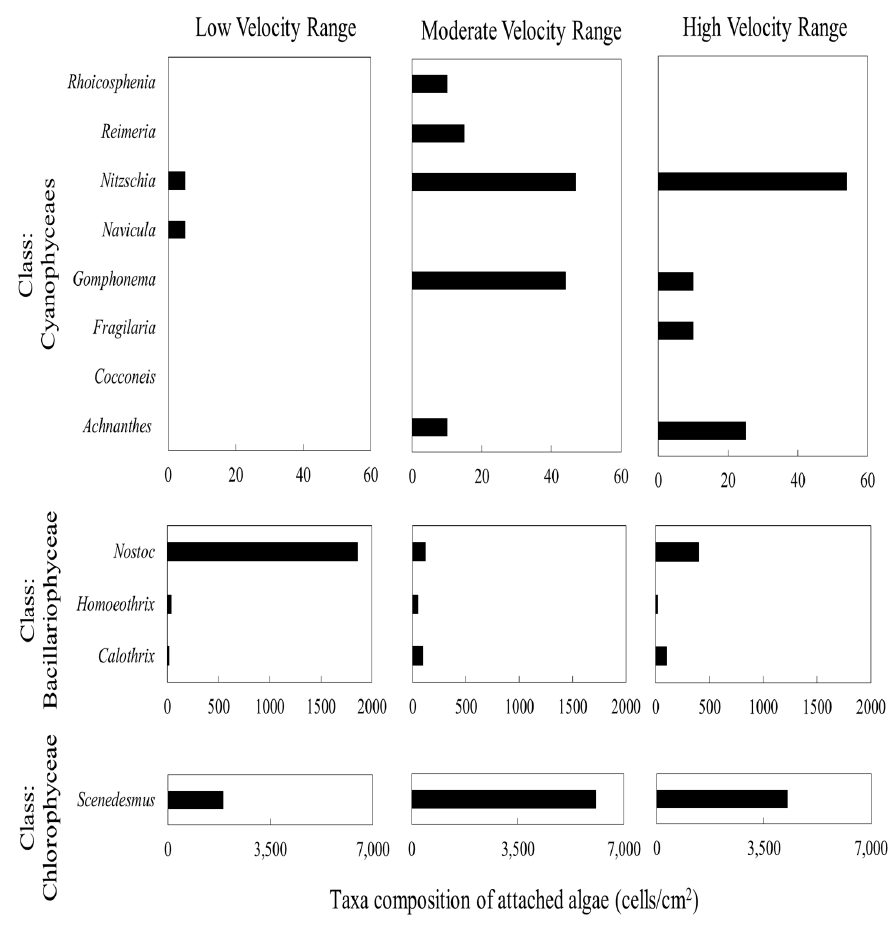
Figure 5. Effect of water velocity on community structure. Taxa composition of attached algae (cells/cm 2 ). The total biomass in the region of moderate near ‐ bed velocity was 6471 cells/cm 2 , corresponding to 1.7 and 1.3 times higher than the lower and higher velocities, respectively. This result is in agreement with our previous observation that near ‐ bed water velocities of 17.9–32.8 cm/s were optimal for periphyton growth.